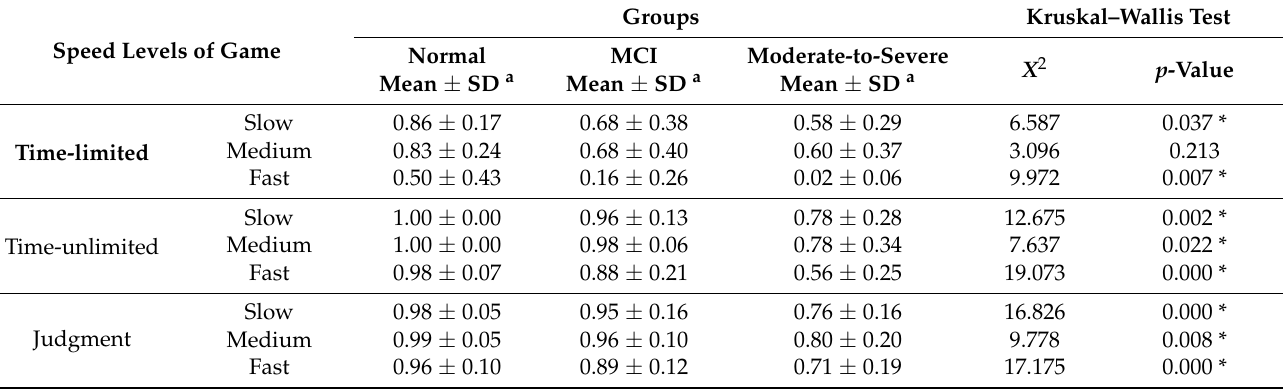
Groups Kruskal–Wallis